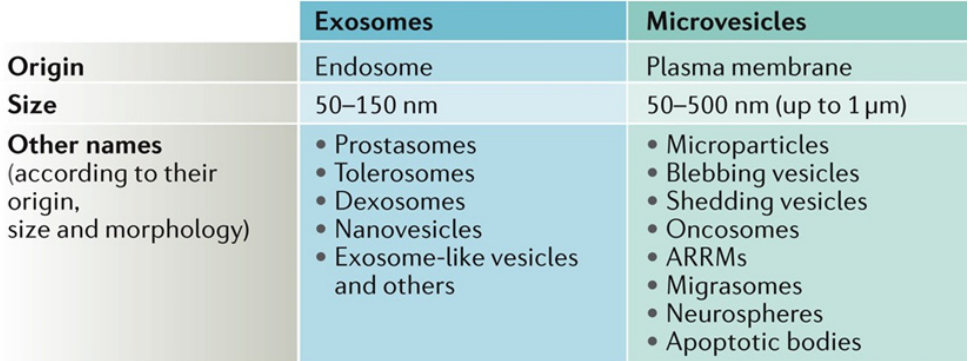
Figure 2. Extracellular vesicles are heterogeneous membrane-bound vesicles that are character- ized based on size and origin. Microvesicles are typically larger (100–1000 nm), whereas exosomes are smaller (50–150 nm). There are a variety of terms used to describe extracellular vesicles, with emerging consensus on defining them as small or large EVs. Reprinted by permission from Springer Nature Customer Service Centre GmbH: Springer Nature, Nature Reviews Molecular Cell Biology [46]